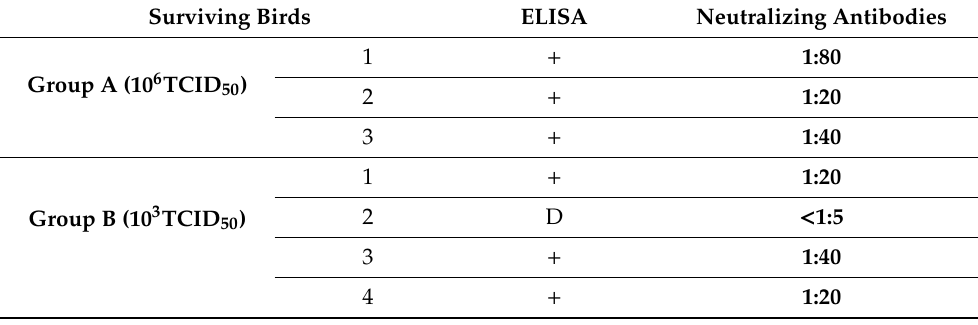
Table 3. USUV-challenged canaries analyzed for antibodies against USUV on day 15 post-infection using the serum neutralization